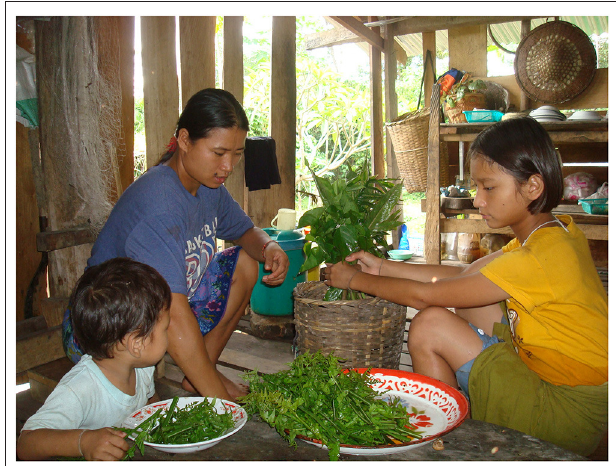
FIGURE 7 | Karen family cooking